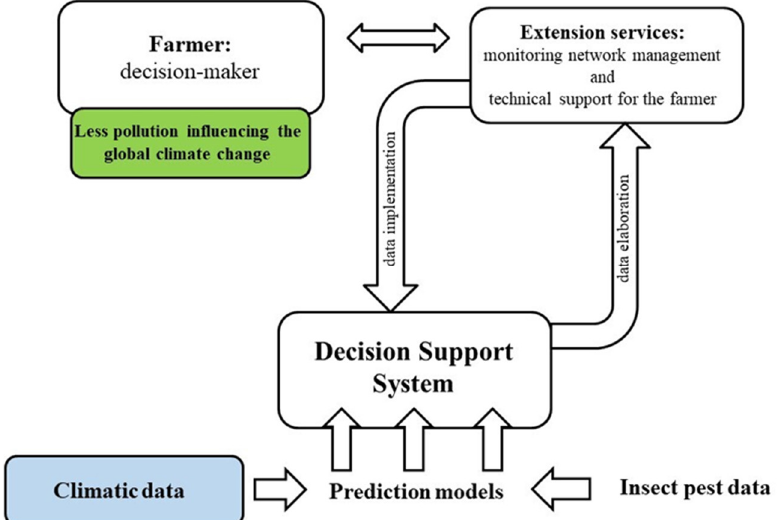
Figure 1. Long-term climatic data are the basis of insect pest prediction models together with insect data obtained by proper monitoring [40]. The decision support systems (DSSs), which bridge the gap between prediction models and extension services, have the task of technically supporting farmers in olive orchard management. In order to abandon scheduled treatments and then to avoid the risk of carrying out unnecessary chemical uses, farmers need a good scenario of the current status of the pest and its potential future trend. As a consequence of a conscious olive orchard management, positive outcomes on the environmental impact and global heating can be recorded (e.g., less air pollution) [49,54,55,96].